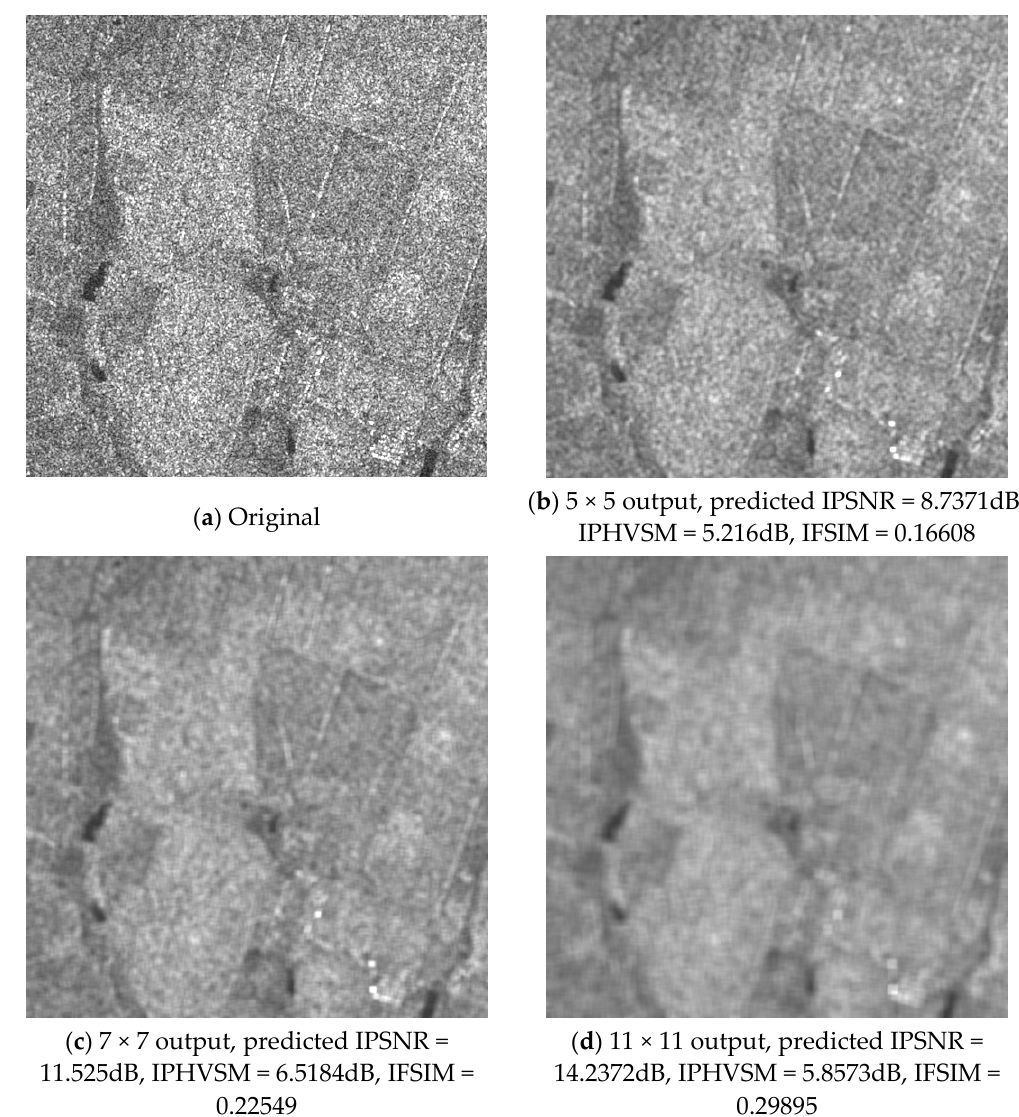
Figure 22. The original Sentinel-1 image ( a ); and the outputs of 5 × 5 ( b ); 7 × 7 ( c ); and 11 × 11 ( d ) Lee filters.